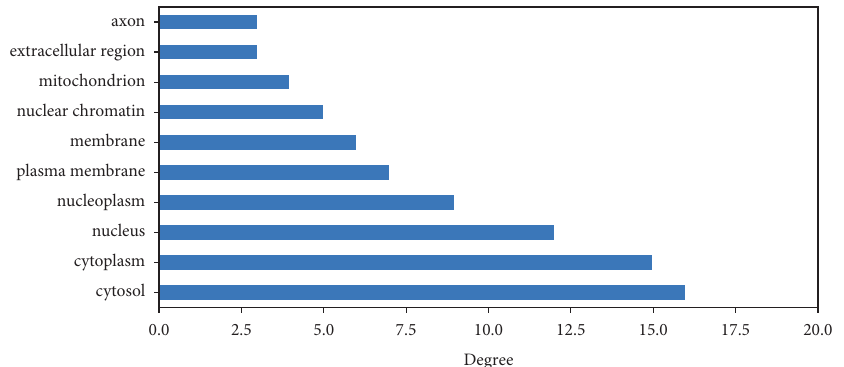
Figure 6: The highest degree of cellular component with important protein.